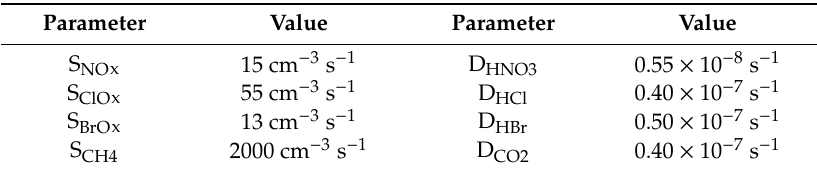
Table 2. Input parameters of the box model.